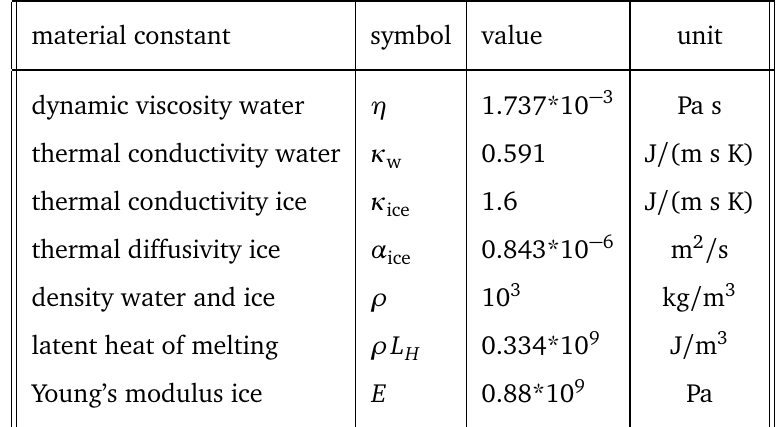
Table 1: material constants of water and